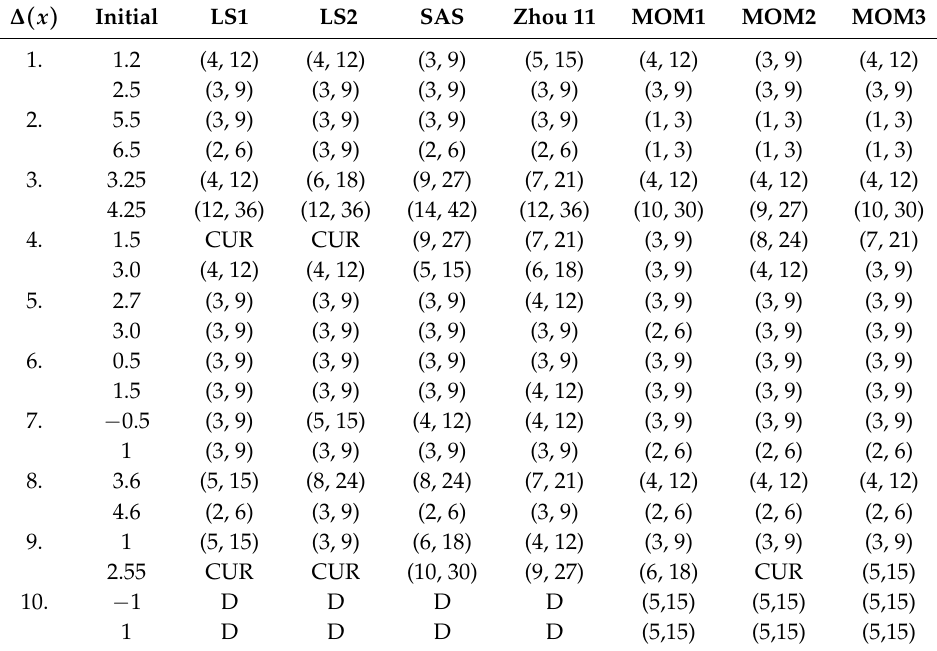
Table 2. Comparison of different iterative